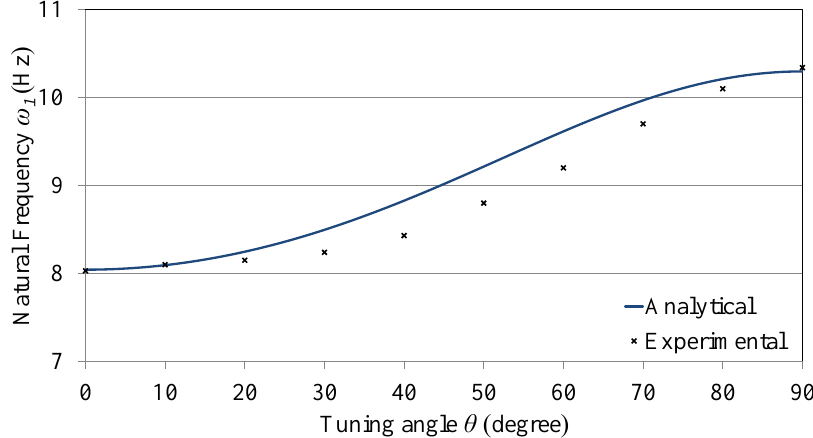
Figure 3. Analytical and experimental natural frequency as a function of the tuning